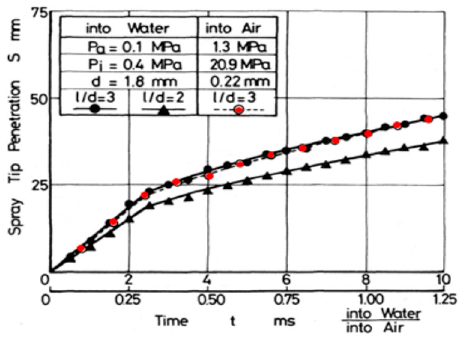
Figure 24. Penetration similarity between fuel-into-air and fuel-into-water injections. Upper timescale is for fuel-into-water spray and lower is for fuel-into-air spray